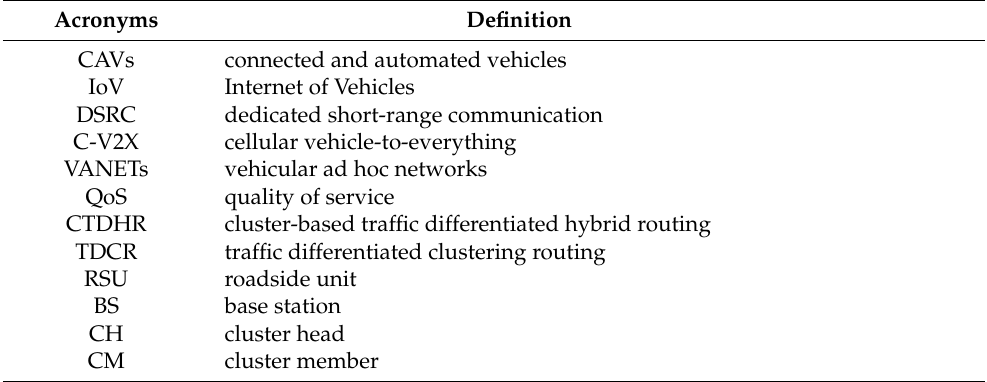
Table 1. Acronyms Used in